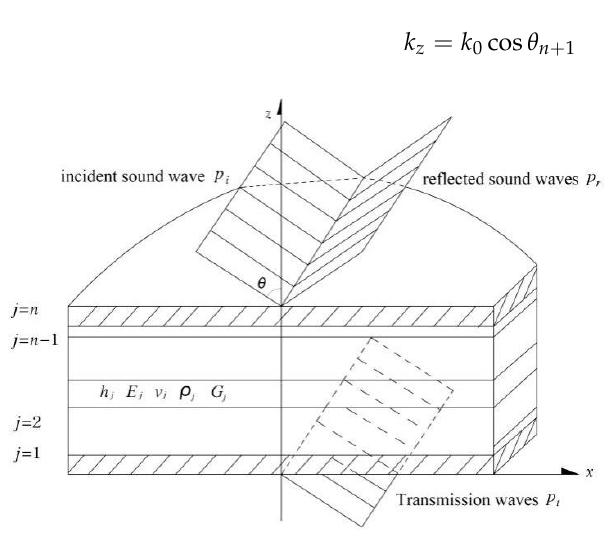
Figure 2. Schematic diagram of calculation model for infinitely damped composite plate.